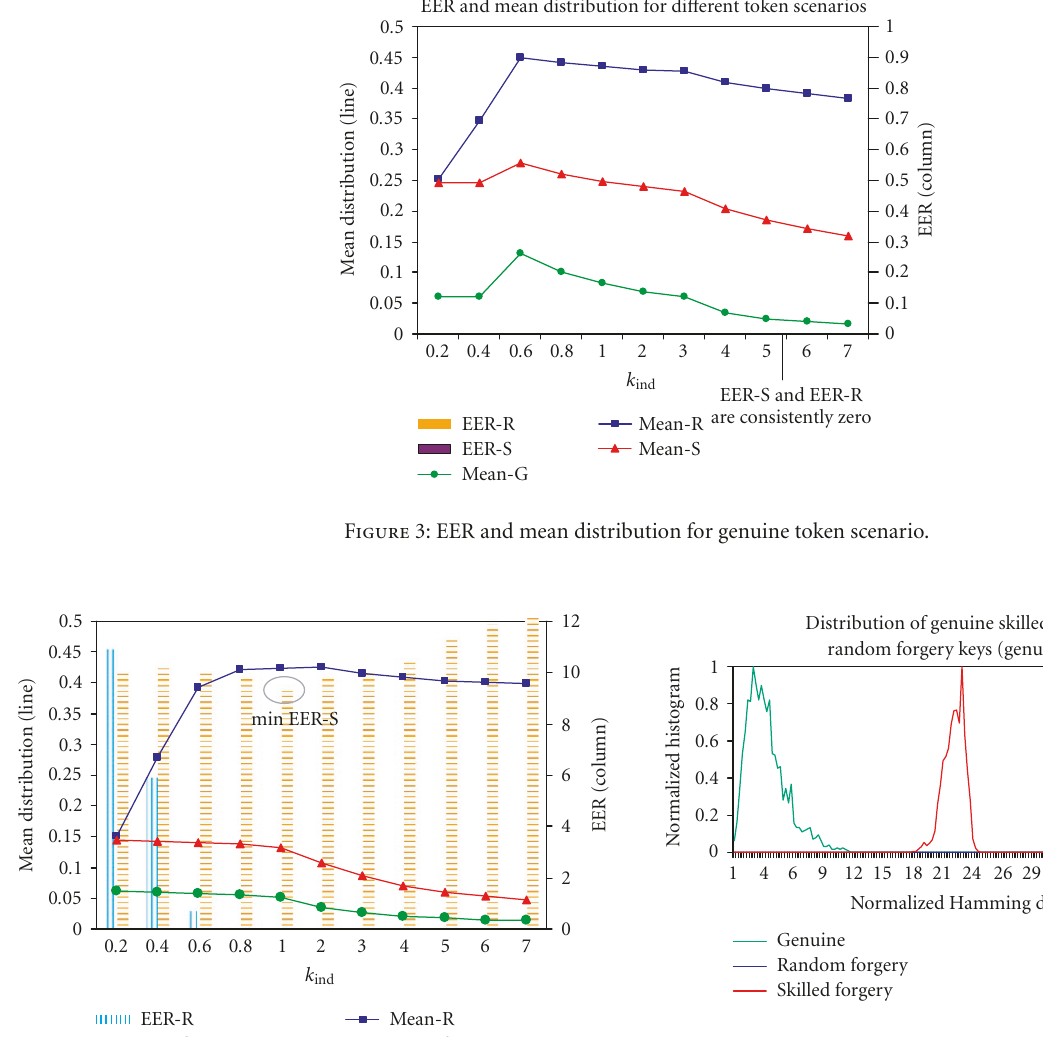
Figure 6: Hamming distribution for genuine token scenario k ind =